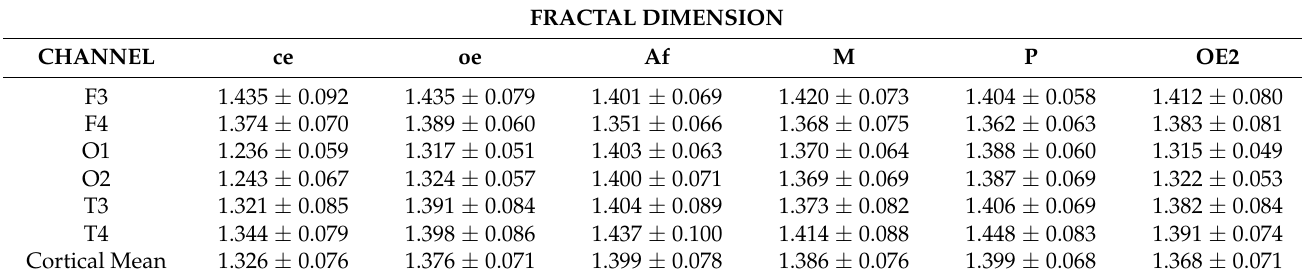
Table 2. Average values of the fractal dimension in each channel (F3, F4, O1, O2, T3, and T4) for each type of EEG, basal states with closed eyes (ce) and open eyes before and after the simulations (oe and oe2), and military vehicle driving simulation tasks (AF, M, P), ( n = 32). The last line shows the cortical average of the six channels for each type of EEG.